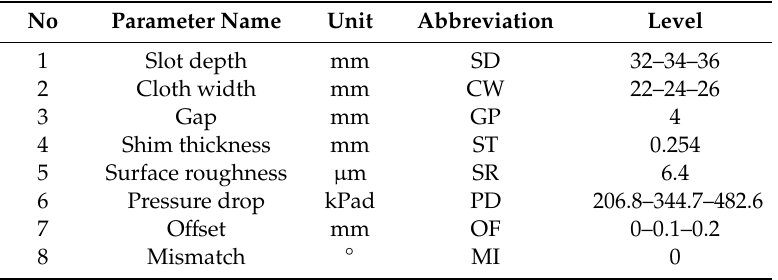
Table 4. The parameters of the main experiments with levels.